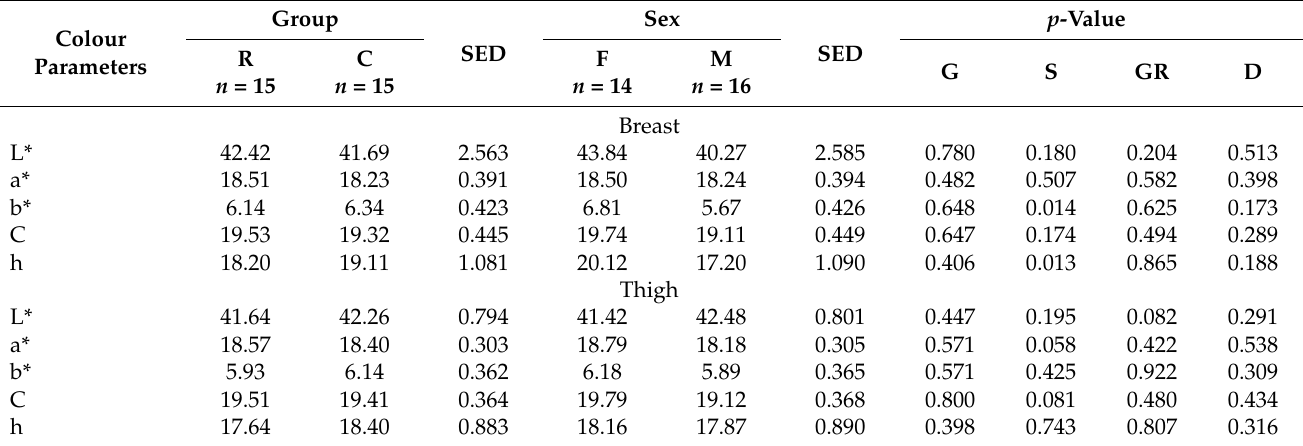
Table 3. Effects of diet and sex on goose meat colour from different anatomical